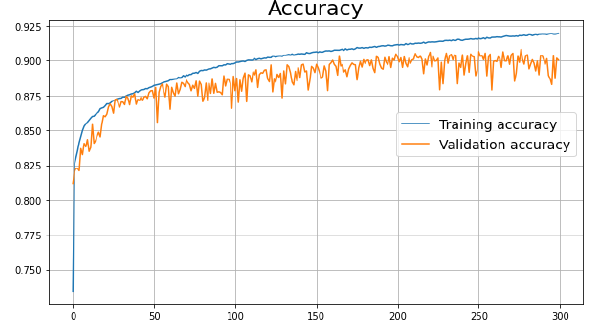
Figure 6. Accuracy graph for the training process on the combined data.